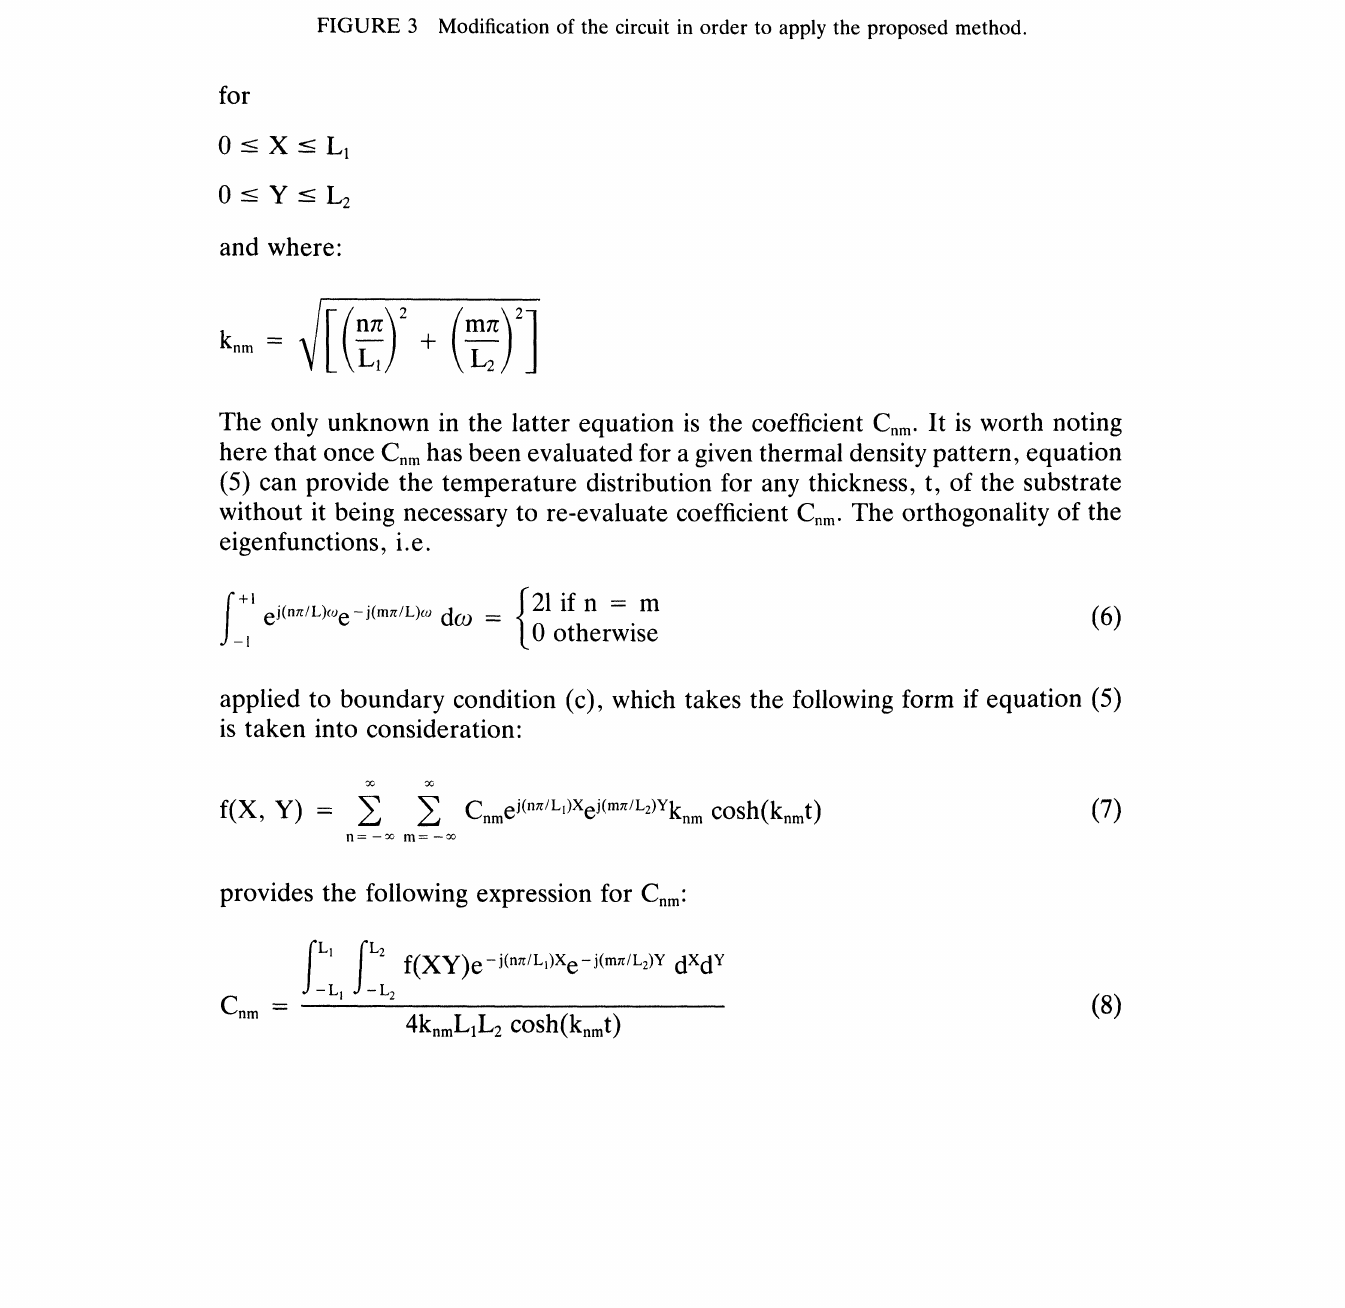
FIGURE 3 Modification of the circuit in order to apply the proposed